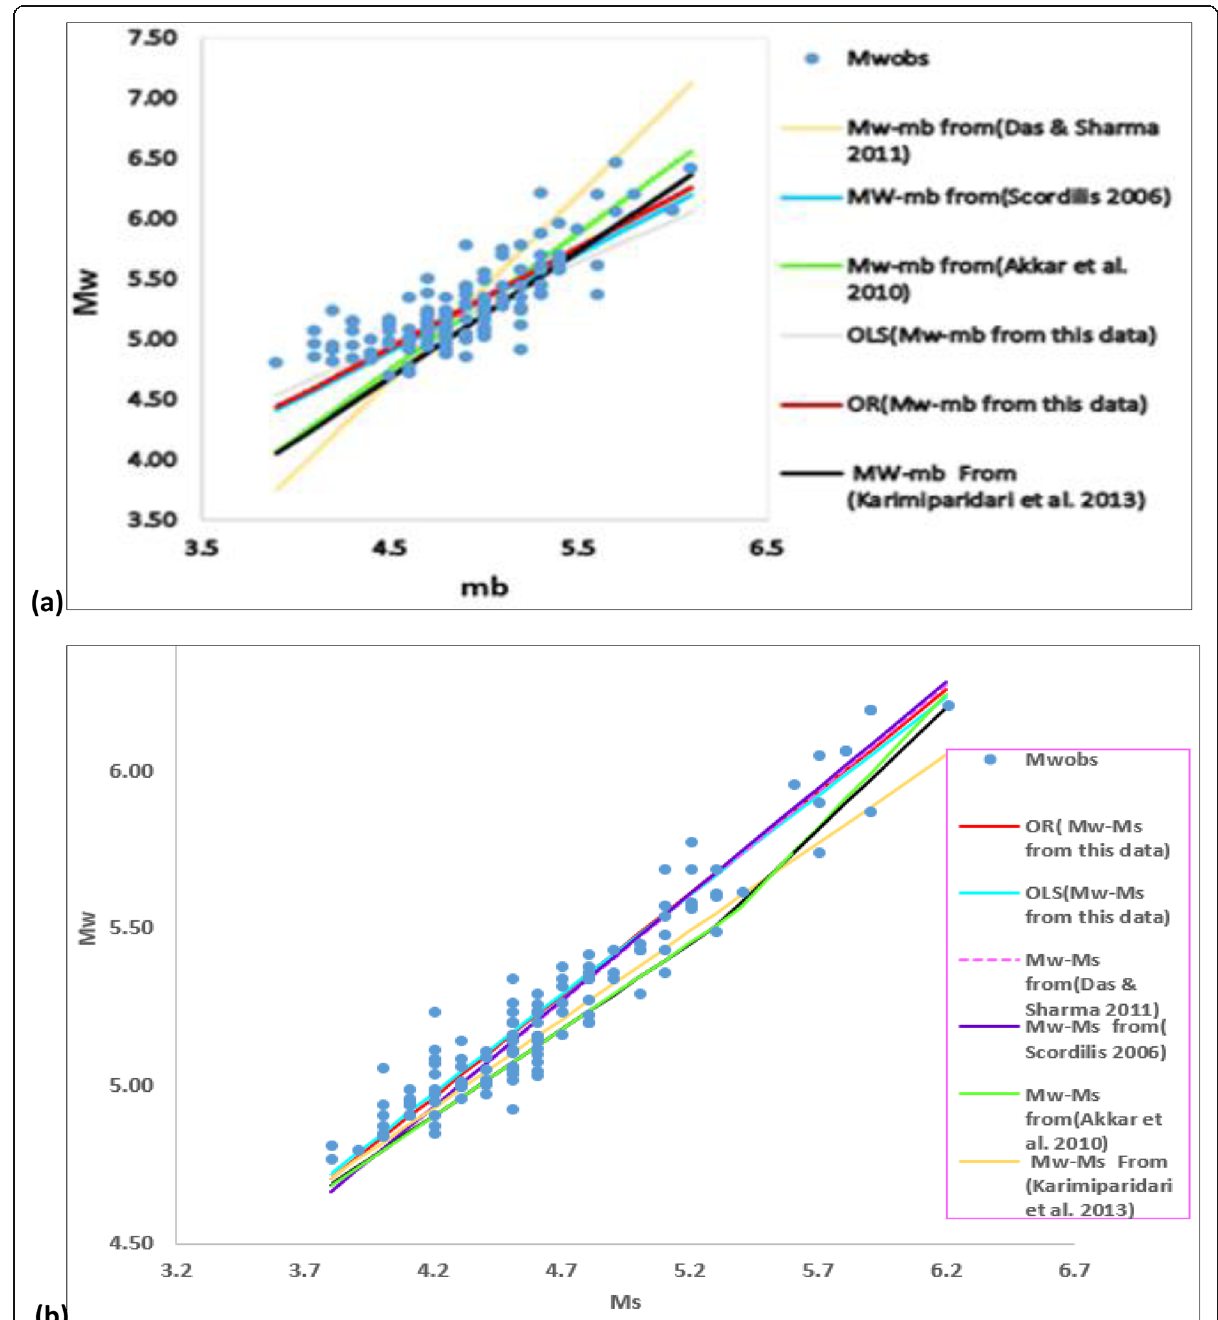
Fig. 3 ( a ) Result comparison MW versus m b of this study and obtained by (Scordilis, 2006; Akkar et al., 2010; Das and Sharma, 2011; Karimiparidari et al., 2013) ( b ) Result comparison MW versus M S of this study and obtained by (Scordilis, 2006; Akkar et al., 2010; Das and Sharma, 2011; Karimiparidari et al., 2013; Kadirioglu and Kartal,